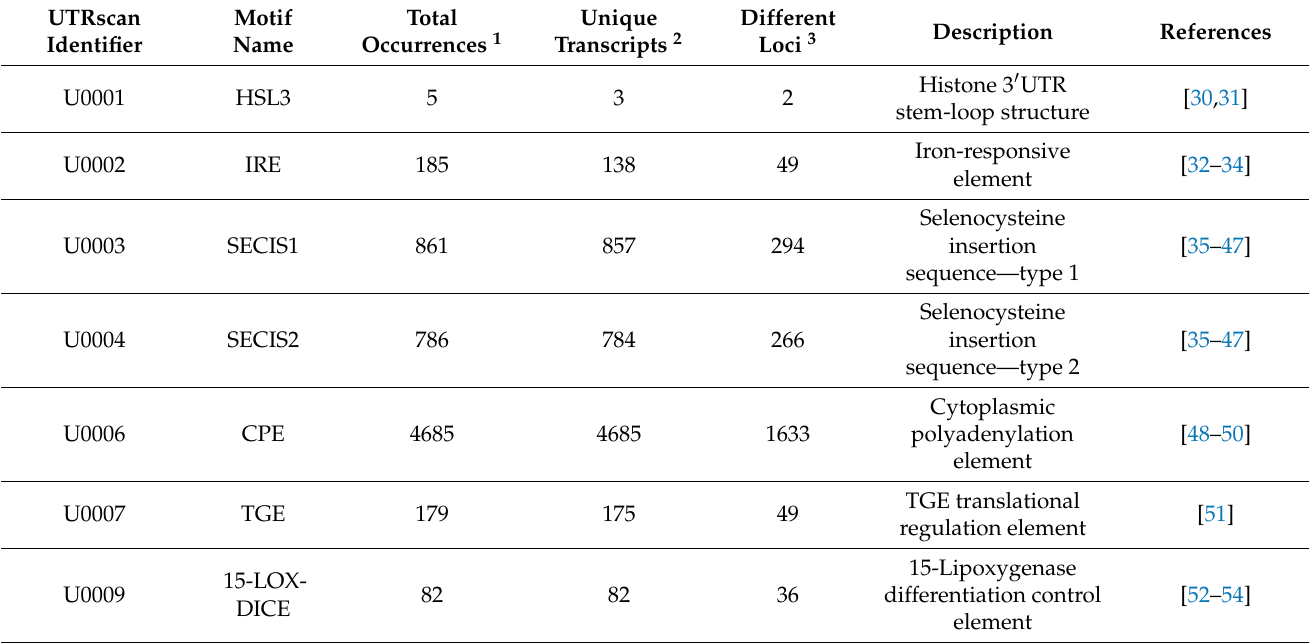
Table 1. Counts, descriptions, and references of all UTRscan motifs identified in at least one 3 (cid:48)